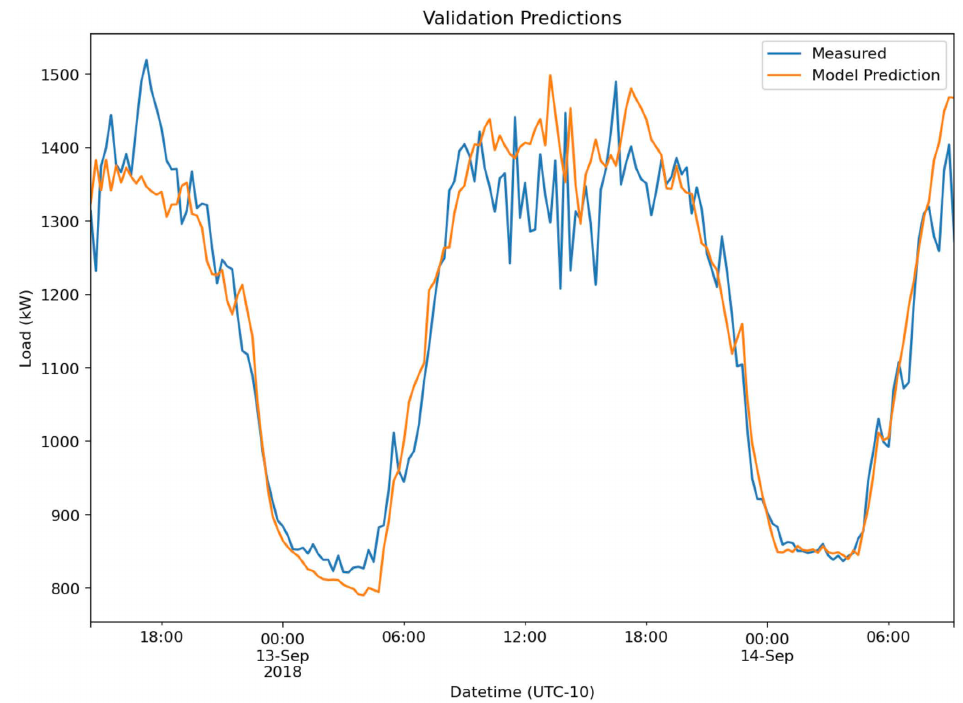
Figure 10. LSTM-EMD forecast model is qualitatively shown to capture some of the non-linearity and high variance, in this case during midday for the Hotel 1 data. The high midday variance in midday measurements and therefore forecast errors is likely due to the hotel operations which are disaggregated (large cooling compressors and fans) and time-ambivalent occupant behavior (compared to morning and evening which are likely more fixed by staff schedules). Table 3. Results